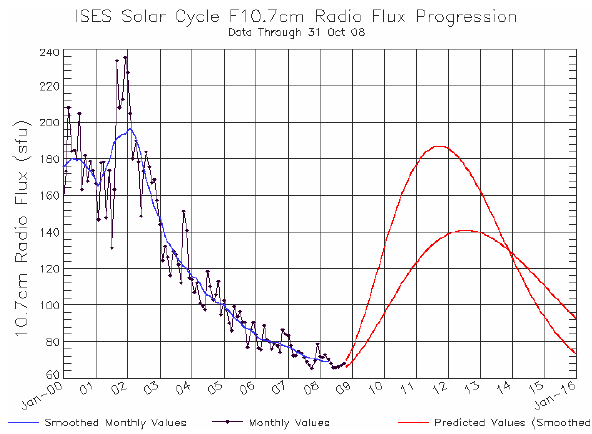
Fig. 1. F10.7 cm Radio Flux observed (2000 to 2008) and predicted (2009-2016) values ( Source: NOAA) Fig. 1. F10.7cm radio flux observed (2000 to 2008) and predicted (2009–2016) values (source: NOAA).